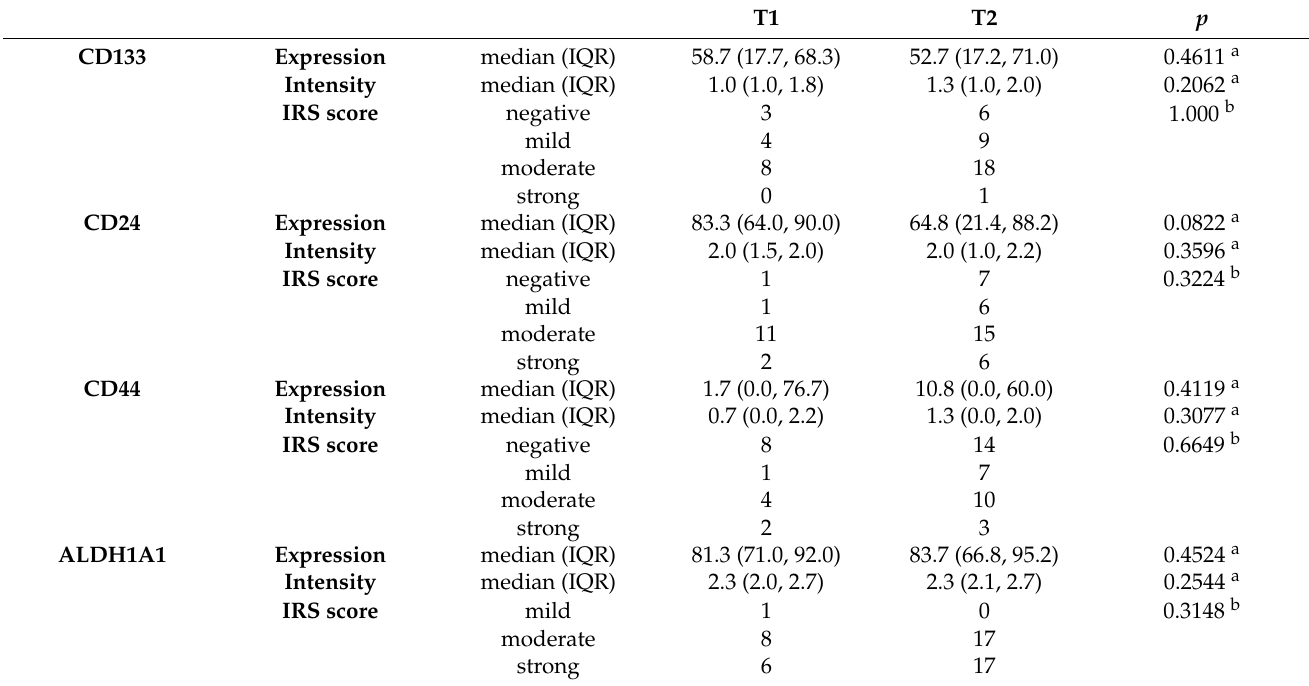
Table 2. Expression of the CSC markers in T1 and T2 tumors.